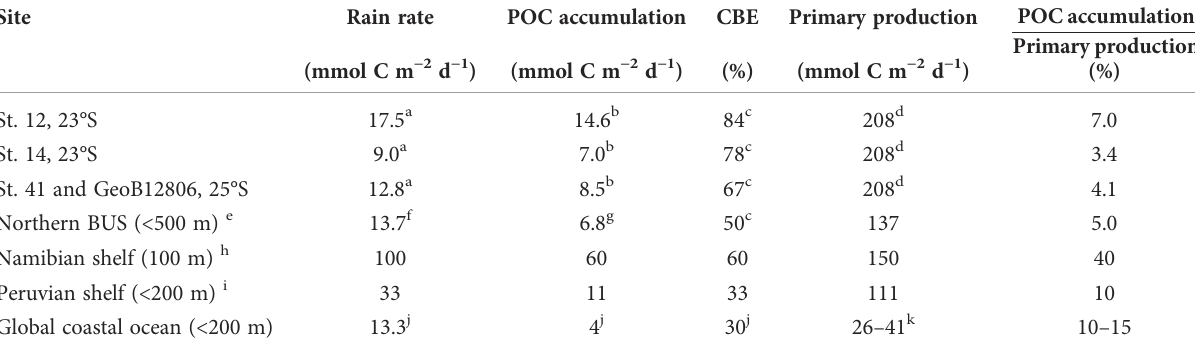
TABLE 1 Organic carbon budget at the three sites in the northern BUS compared with published